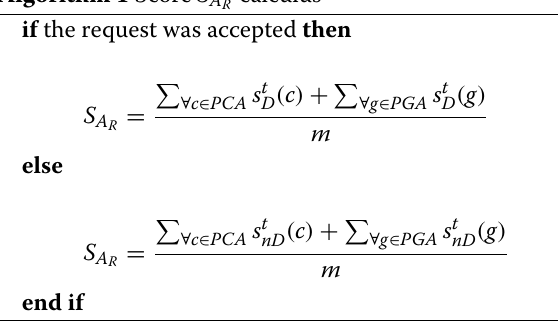
Algorithm 1 Score S A R